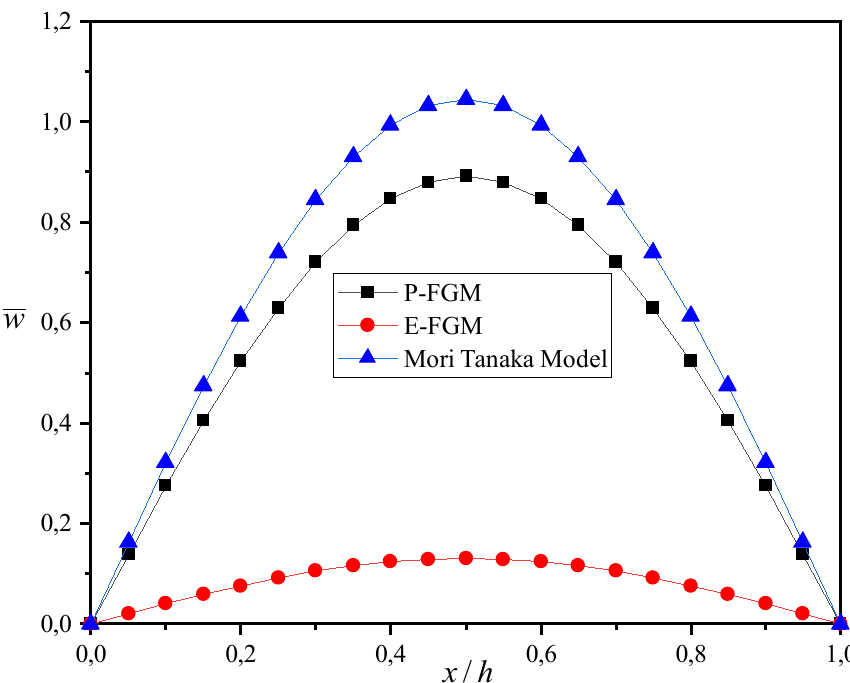
Figure 7. Comparison of the deflection of the Mori–Tanaka model and P-FGM and E-FGM plates ( a / h = 4, k =